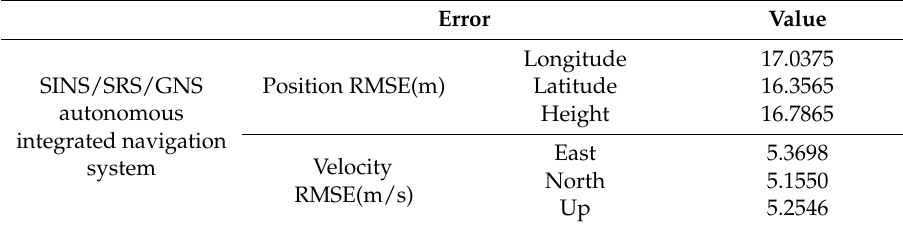
Table 3. The error statistics of the autonomous integrated navigation system.